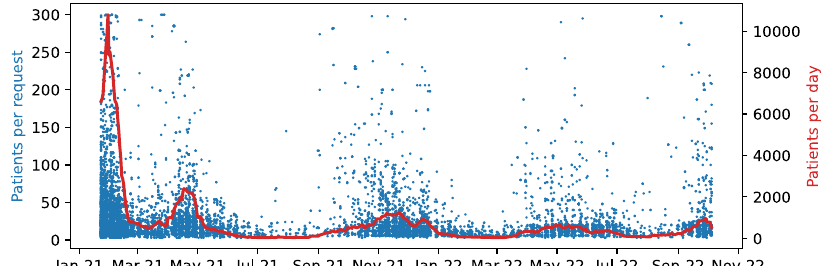
Fig. 2 Time series of Vaximap use. Peaks assumed to correspond to the majority of fi rst (Jan 21) and second doses (Apr 21) can be discerned, as can booster doses (Nov 21, May 22 and Oct 22). The red line is the 30-day moving average of total uploaded patients per day. A few uploads of the maximum permitted number of patients (300 patients) can be